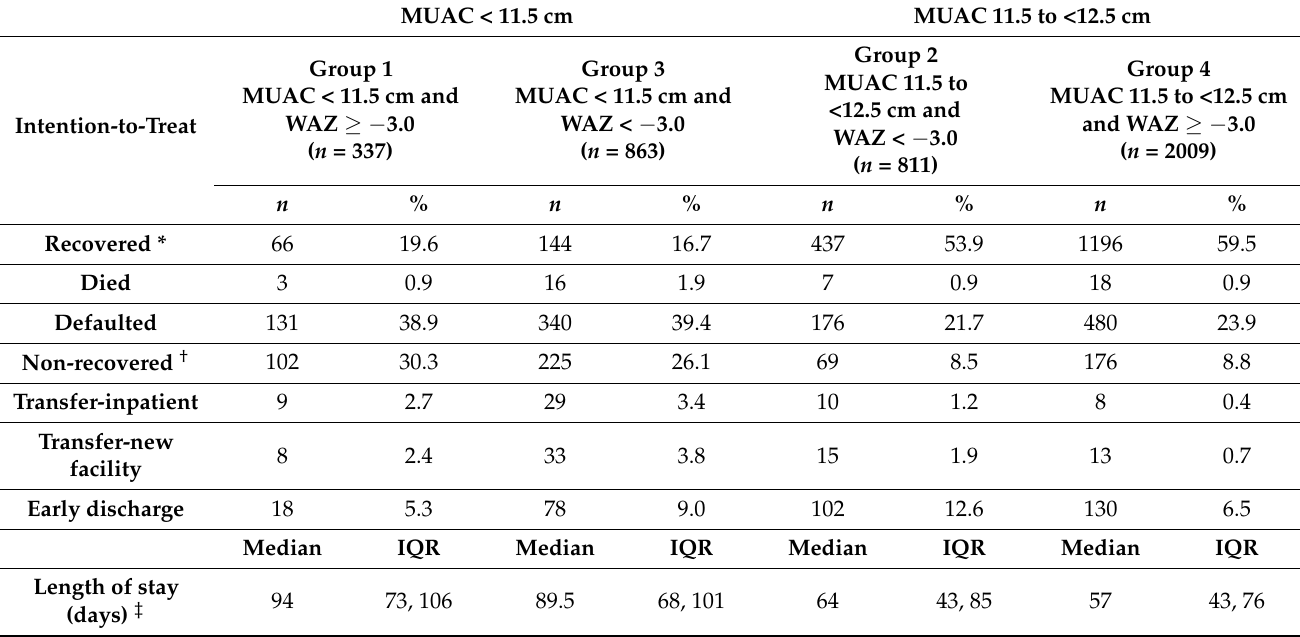
Table 5. Outcomes of children, by admission